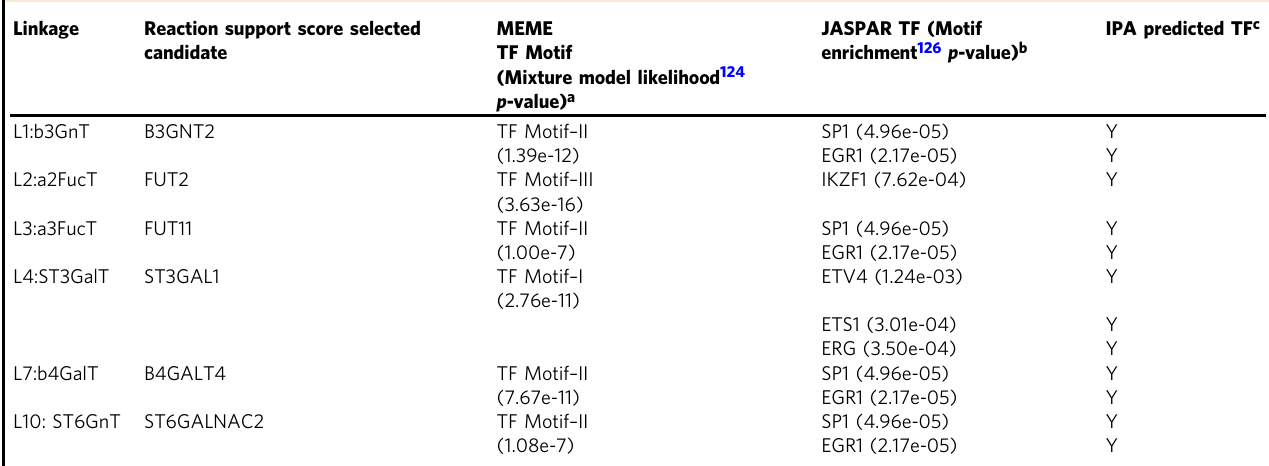
Table 2 TF motif (MEME) and IPA upstream regulator integrated results. Linkage